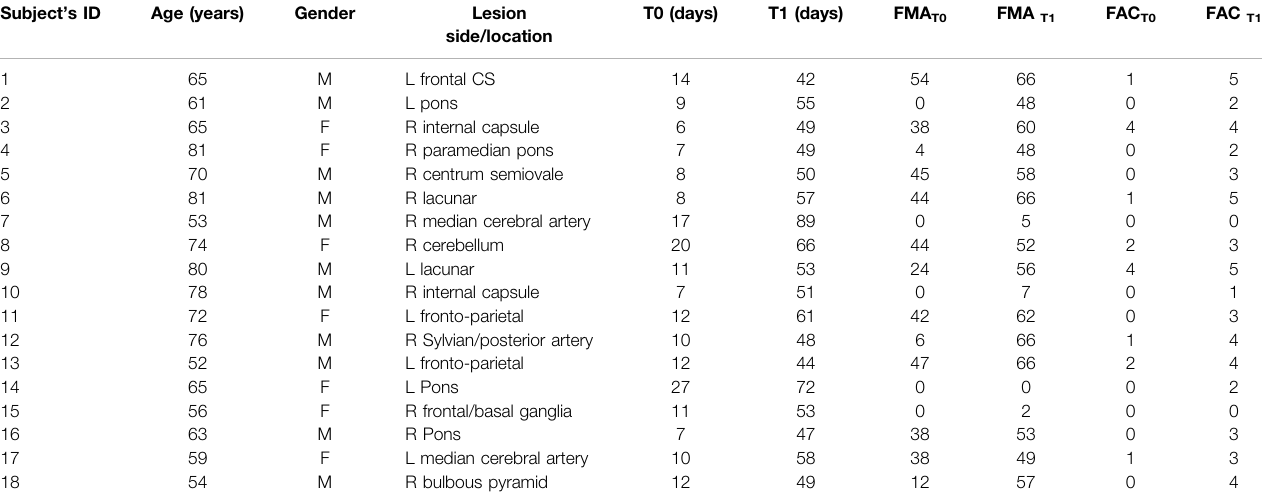
TABLE 1 | Participants ’ characteristics.